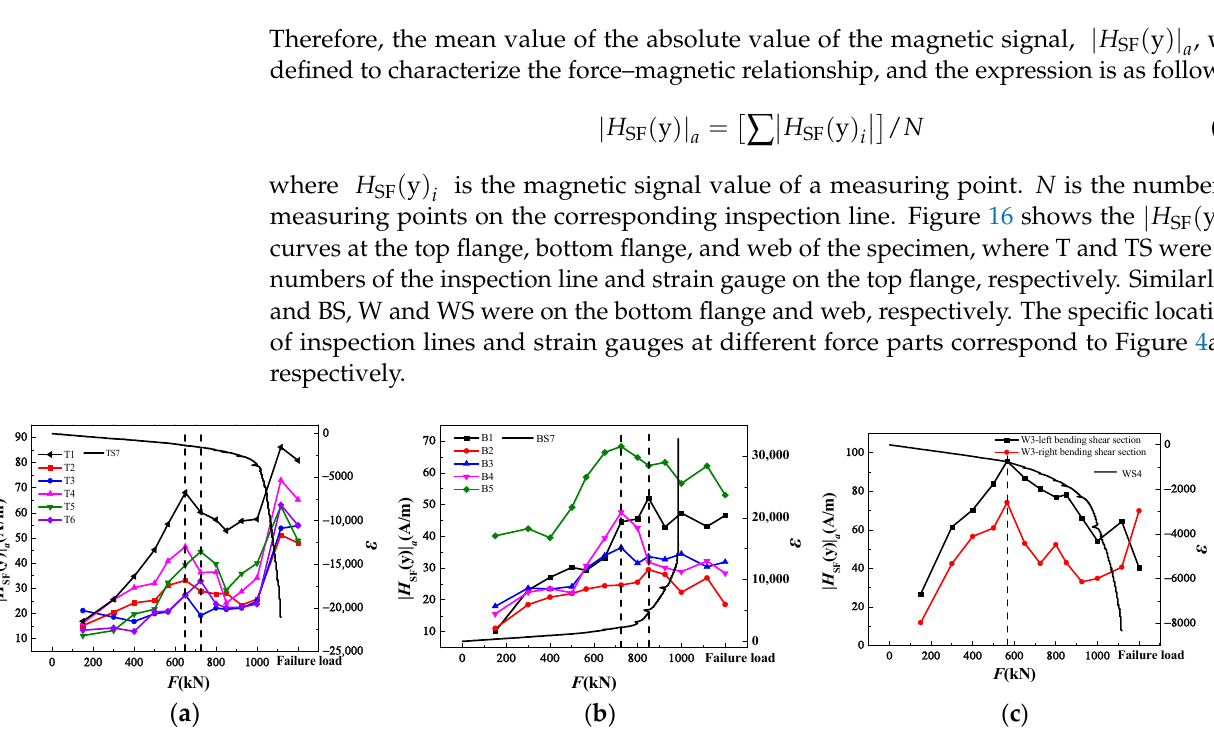
Figure 16. | 𝐻 (cid:2903)(cid:2890) (y)| (cid:3028) - F relationship curves: ( a ) top flange; ( b ) bottom flange; ( c ) web. Figure 16. | H ( y ) | - F relationship curves: ( a ) top flange; ( b ) bottom flange; ( c ) SF a